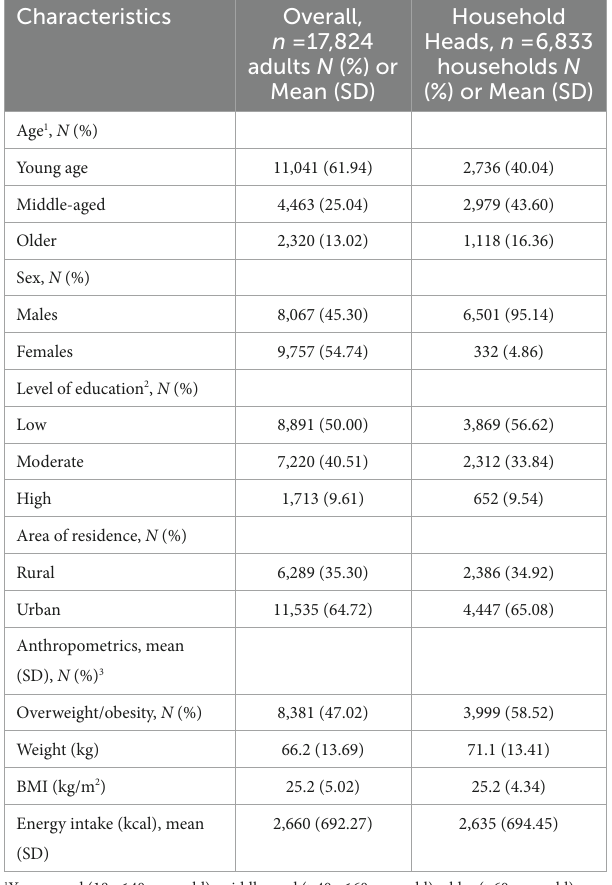
TABLE 1 Characteristics of Iranian adults overall and by household